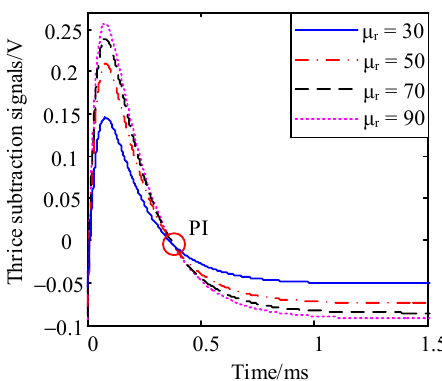
Figure 9. Thrice subtraction signals. Permeability invariance (PI) is shown by the red circle at the intersection of the signals.